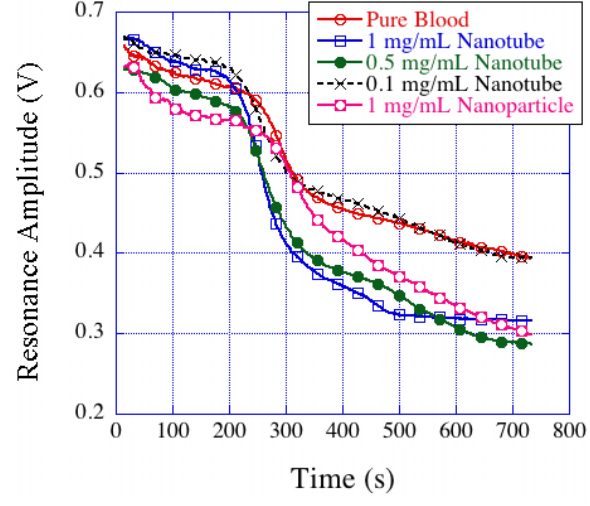
Figure 33. Resonance amplitude vs. time profiles of magnetoelastic sensors immersed in nanotube-mixed blood samples. The addition of TiO TiO 2 results in a greater clot strength and faster rate of clot formation. Reprinted with permission from